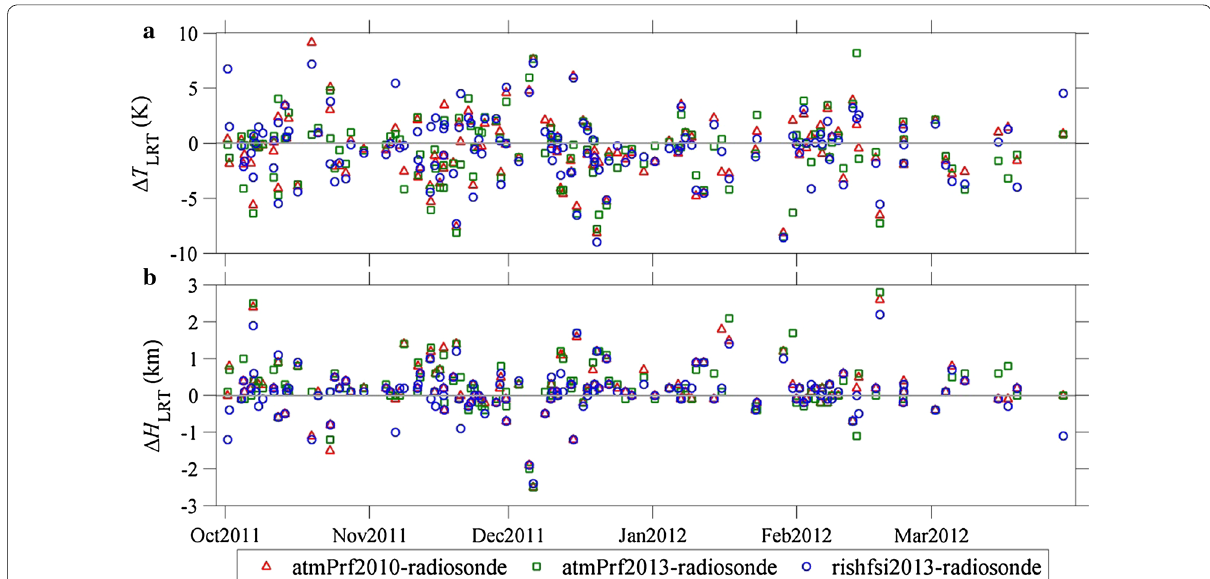
Fig. 9 Individual comparisons between COSMIC GPS-RO and a radiosonde for a ∆ T LRT and b ∆ H LRT . Tick marks on the horizontal axis indicate the first day of the corresponding month